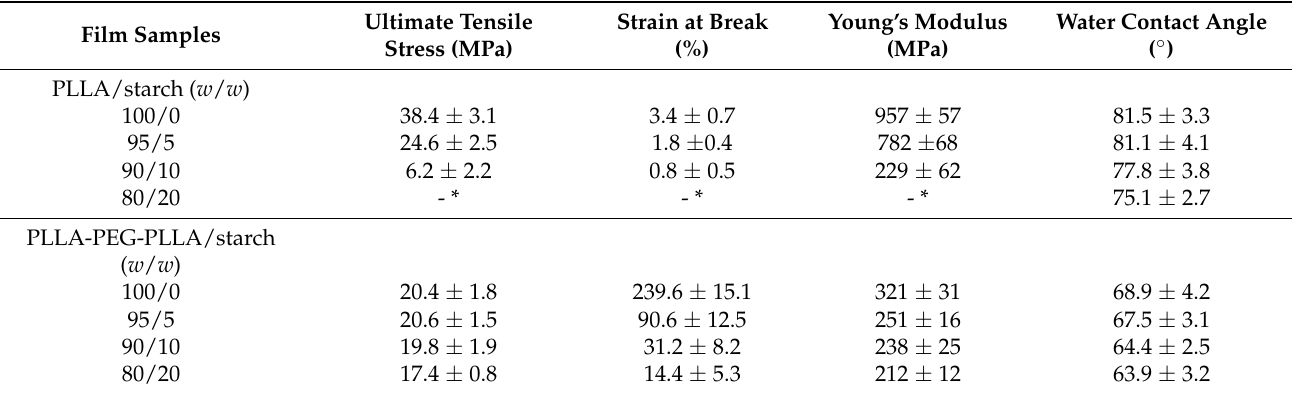
Figure 8. Selected tensile curves of ( above ) PLLA/starch and ( below ) PLLA-PEG-PLLA/starch films with various blend ratios (* 80/20 PLLA/starch film was not determined). Table 3. Tensile properties and water contact angles of PLLA/starch and PLLA-PEG-PLLA/starch films.